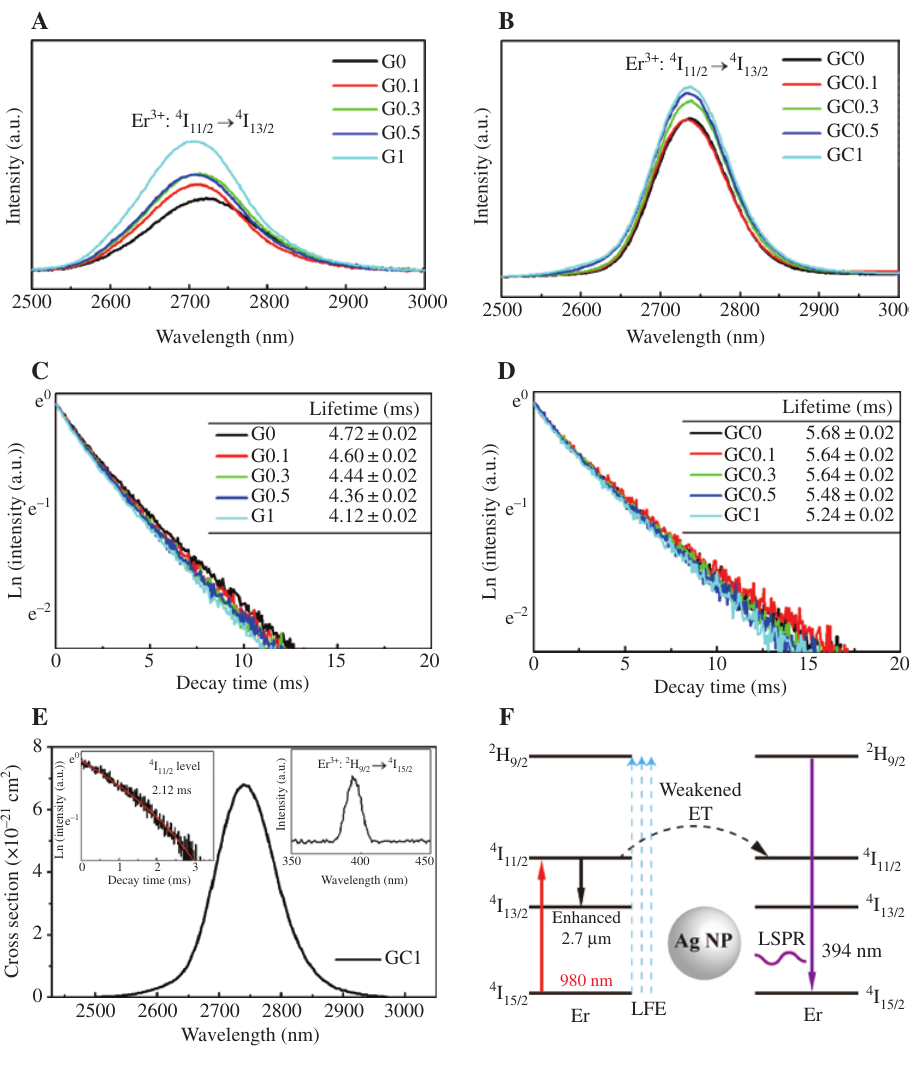
Figure 4: Mid-infrared emission properties of glass and GCs. The 2.7 μ m emissions of glasses (A) and GCs (B); decay curves and lifetime of 4 I level in glasses (C) and GCs (D); (E) calculated emis- 13/2 sion cross section in 2.7 μ m, lifetime of the 4 I level (inset at the left), and upconversion emission spectrum (inset at the right) of the 11/2 GC1 sample; (F) schematic simplified energy level diagram of Er 3 + ions and the fluorescence enhancement